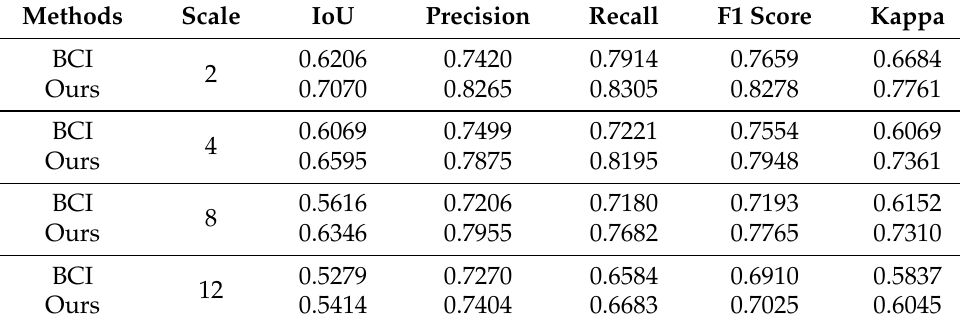
Table 3. Quantitative evaluation of the results of building extraction.